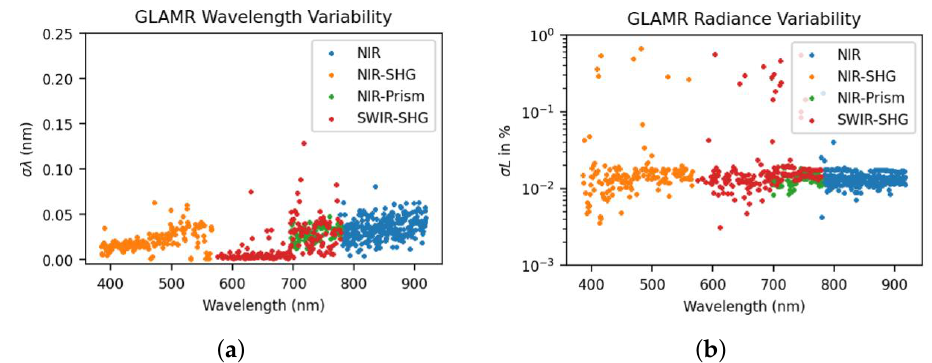
Figure 7. The variability of GLAMR ( a ) wavelength and ( b ) radiance during 8 March 2019 measurements.